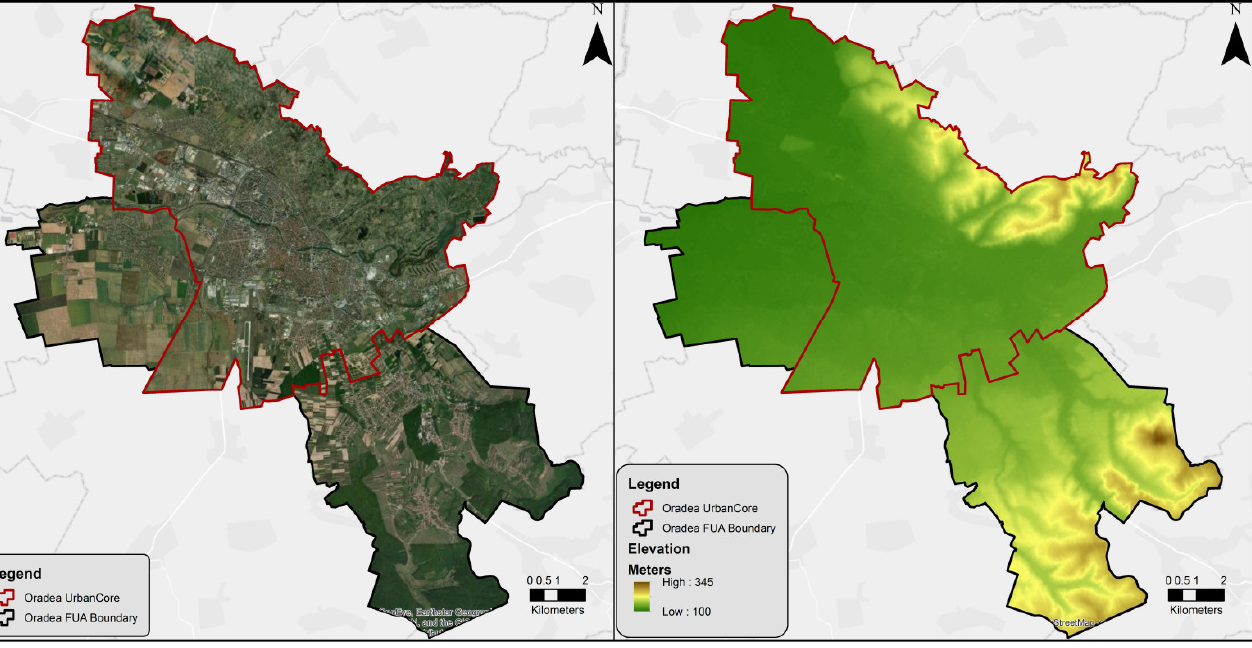
Figure 6. Satellite imagery- true color ( left ) and digital elevation model ( right ) for the 3rd case study: Oradea.